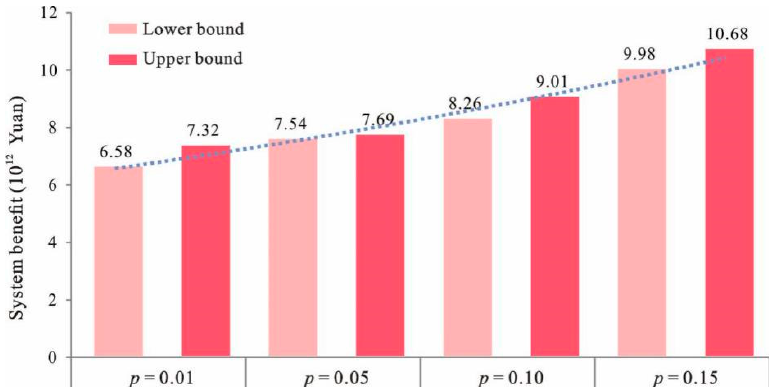
Figure 6. Relationship between p levels and system benefit.